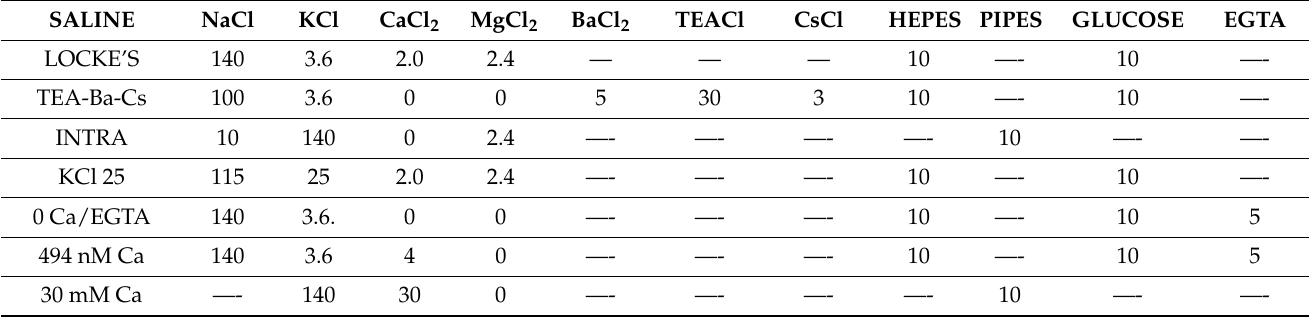
---- The activation parameter’s maximal conductance (g Ca ), half-activation voltage (V 0.5 ), and inverse slope factor (S) were estimated by the best fits of Equation (1) (see Data Anal- ysis in Section 4) to experimental recordings, and their average values plotted in Figure 1c–e, respectively. In five WT and five MUT rods, mean values (±SEM) were: maximal conductance (g Ca ) 0.29 (± 0.06) and 0.10 (± 0.05) nS; half-activation voltages (V 0.5 ) − 28.17 (± 6.16) and − 10.52 (± 3.20) mV; and inverse slope factors (S) 9.80 (± 1.88) and 10.41 (± 1.37) mV. Significant differences between WT and MUT were found for V 0.5 and g Ca (* p < 0.05; see Figure legend), indicating that the Cacna2d4 mutation affects VGCC by shifting its ac- tivation to depolarized potentials and reducing its maximal conductance.